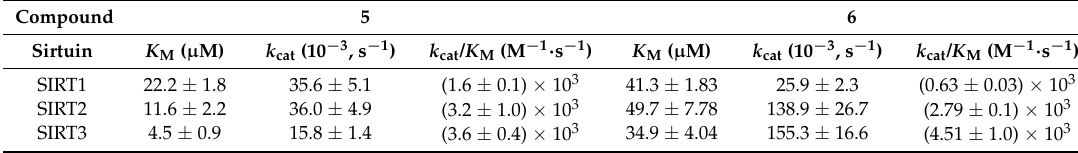
a See Experimental Section for assay